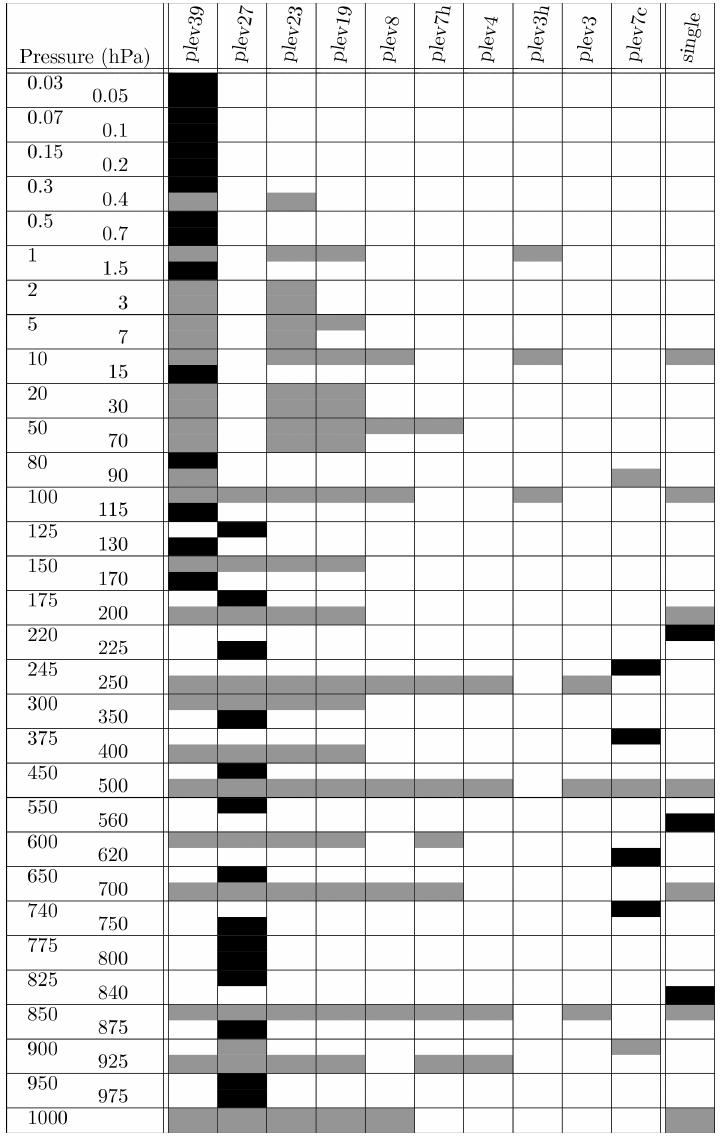
Table 4. The pressure levels used for atmospheric variables in the DREQ. The right-hand column, titled “single”, contains pressure levels used for single-level variables. Other columns represent collections of levels used as a vertical axis for a range of requested parameters. Black rectangles indicate a level which occurs in only one column. The plev7c axis is a special case that is used specifically to match diagnostics from the International Satellite Cloud Climatology Project (ISCCP; WCRP, 1982) cloud simulator. The three black rectangles in the “single” column, at 220, 560 and 840hPa are also ISCCP